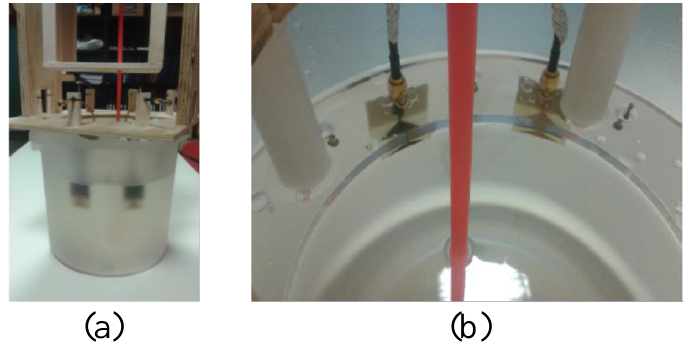
Figure 12. Photograph of a breast cancer detection system developed by Pagliari et al. [69]. ( a ) View of the antennas’ setup showing the breast holder consisting of a tank filled with a glycerine-water mixture. ( b ) Photograph of a vertically aligned cylinder representing the detection target. Reprinted with permission from [69].